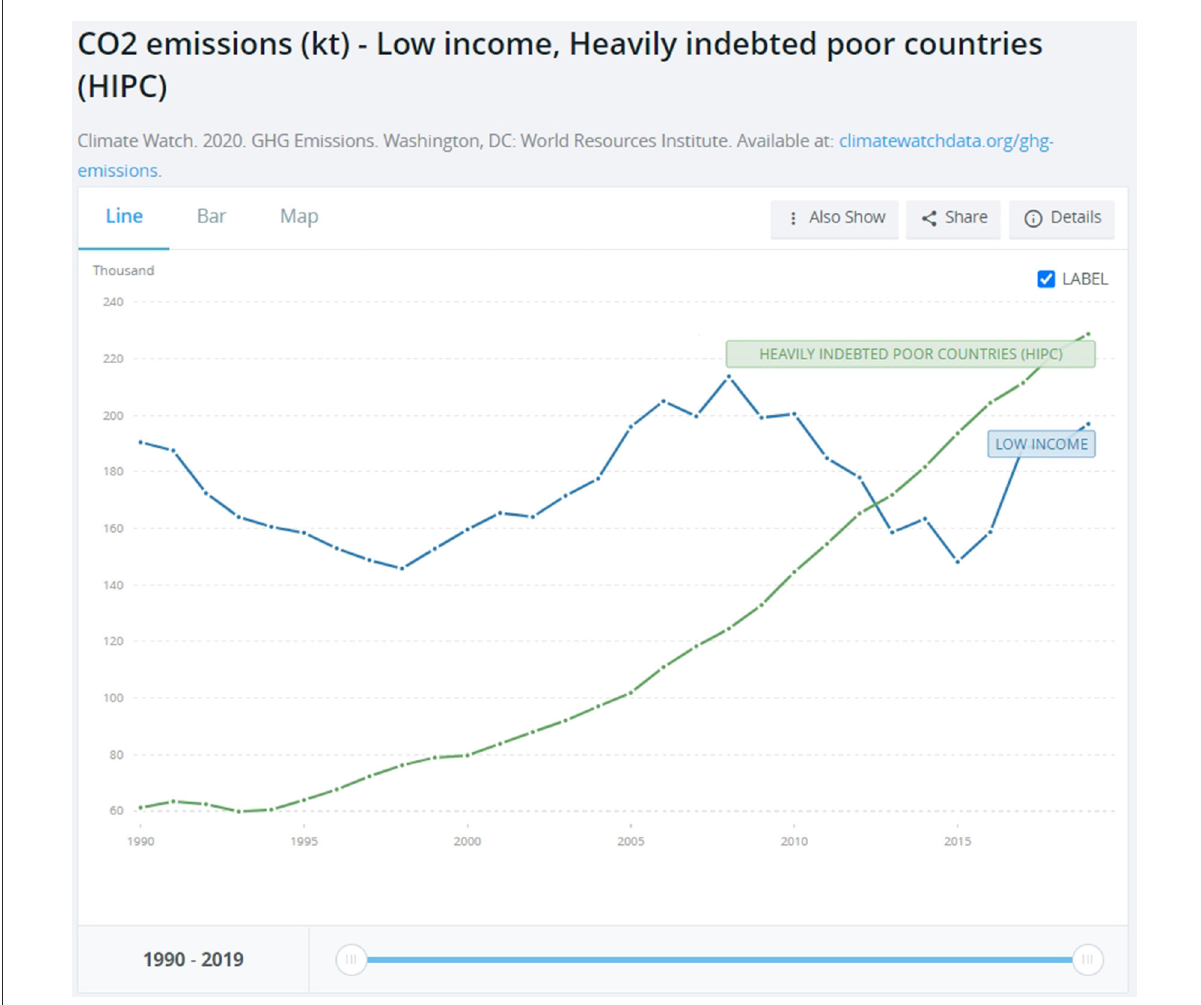
FIGURE4 Share of CO2 emissions, low income and heavily independent poor countries. Notice the shift from Million to Thousand tons of carbon dioxide Year: 1990–2019. Source: World Bank at https://data.worldbank.org/indicator/EN.ATM.CO2E.KT?contextual=default&end=2019&locations= XM-XE&most_recent_year_desc=false&start=1990&view=chart (accessed August 10,